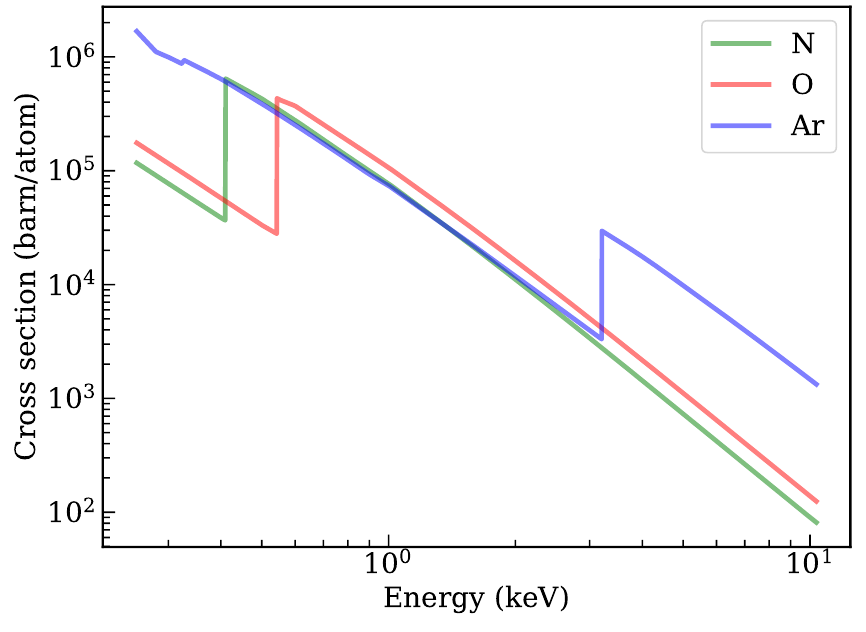
Figure 1. X-ray cross sections of N, O, Ar in the 0.25 keV to 12 keV energy range. The K-shell absorption edges are clearly visible (0.4 keV, 0.53 keV and 3.2 keV for N, O and Ar). The cross sections at K-shell absorption edges of N, O and Ar are clearly different, which provides an opportunity to retrieve atmospheric densities of different elements.